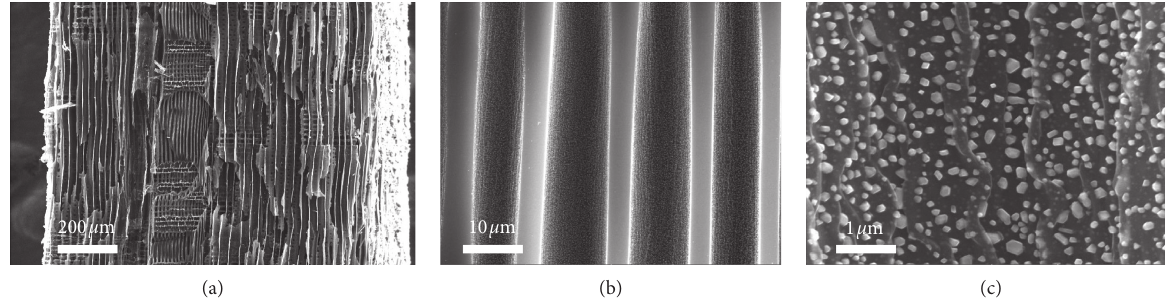
Figure 4: SEM images of Ni 2 P-Ni 12 P 5 /CW at different magnifications.